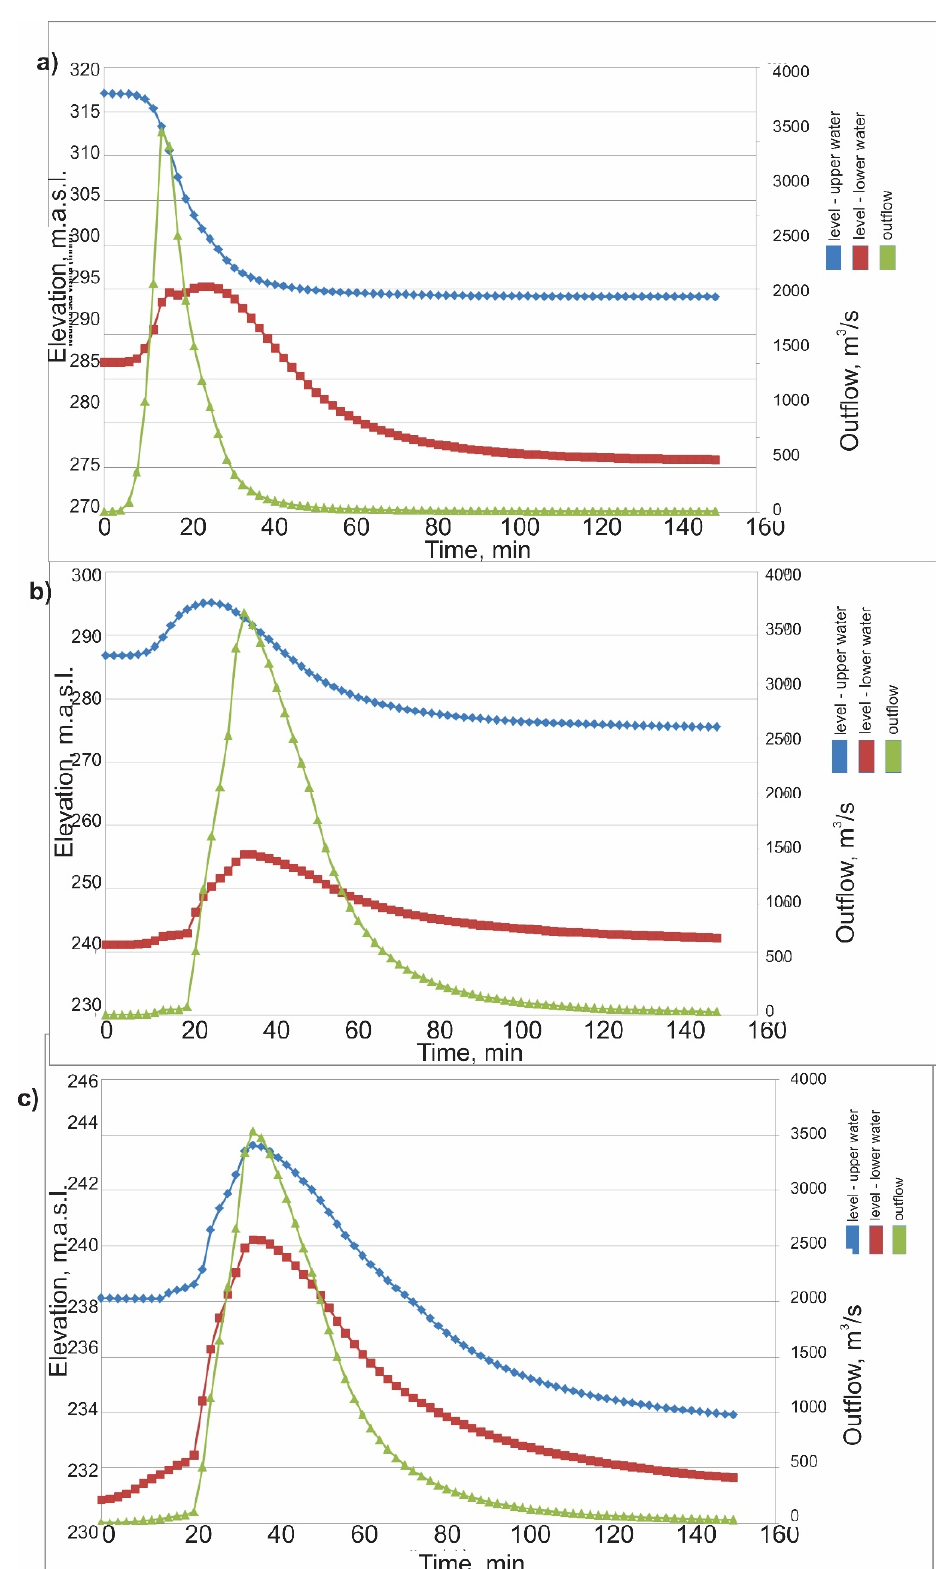
Figure 8. Flow and stage hydrographs: ( a ) dam 1, ( b ) dam 2, ( c ) dam 3 [20]. Reproduced with permission from author and publisher Mining and Metallurgy Institute Bor (MMI Bor), Serbia Zijin Mining doo Bor, Detailed Mining Design – Mineral Processing and Disposal of Tailings and Pyrite Concentrate from Cukaru Peki Deposit – Upper Zone, Bor, 2020.